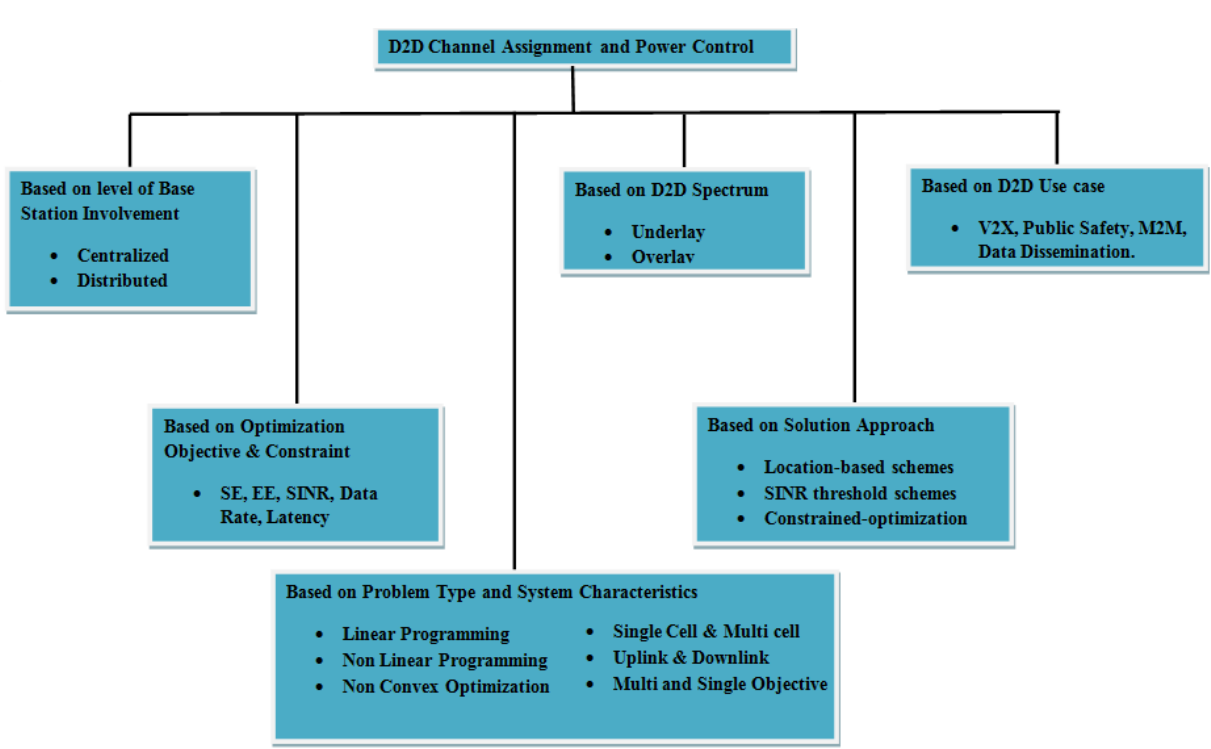
Figure 7. Classification of D2D resource assignment and power